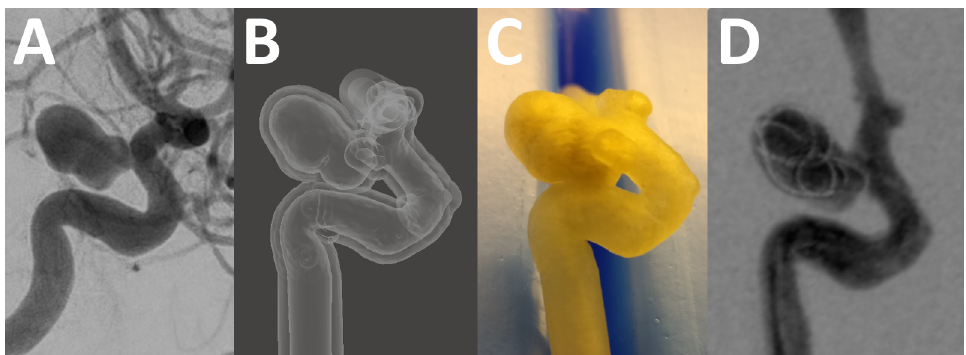
Fig 1. Model fabrication. A, Digital subtraction angiography from a patient with a left-sided internal carotid artery aneurysm originating at the posterior communicating artery origin. B, Hollowed surface data after postprocessing, before manufacturing. C, Photograph of the model after manufacturing. D, A single frame from high-frequency digital subtraction angiography in the model, obtained with a MED framer device deployed in the aneurysm